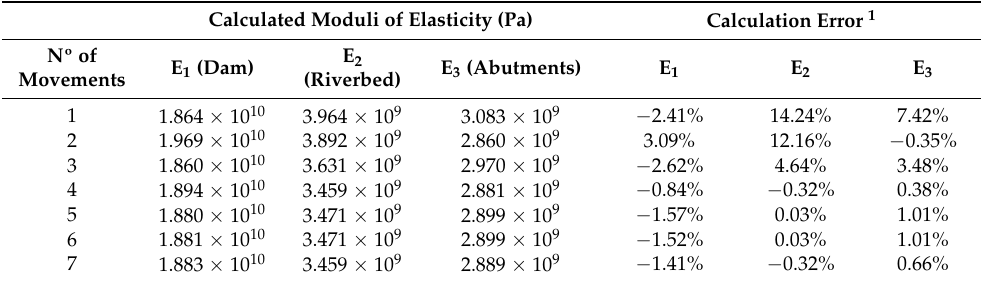
Table 3. Calibrated elasticity moduli for sectorization 2: dam and foundation divided into riverbed and abutments.